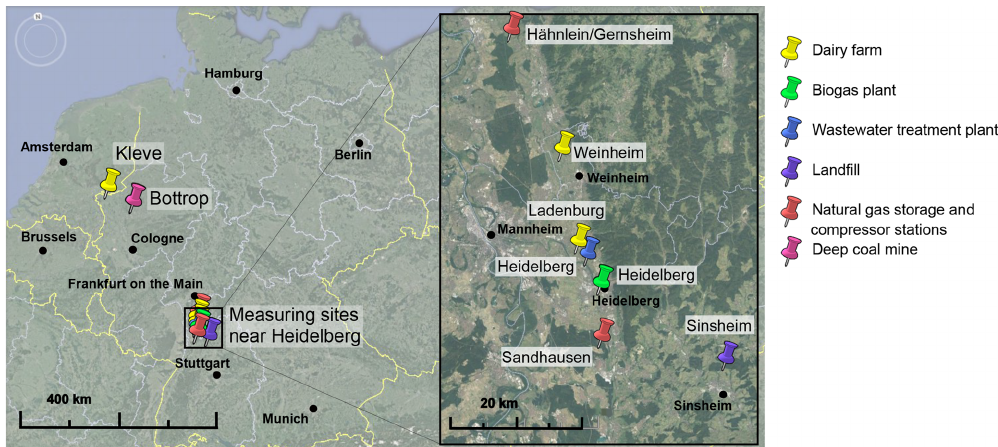
Figure 8. Locations of the measuring sites. Map data: Google Earth, 2017 Google; Image Landsat/Copernicus, 2009 GeoBasis-DE/BKG, US Dept of State